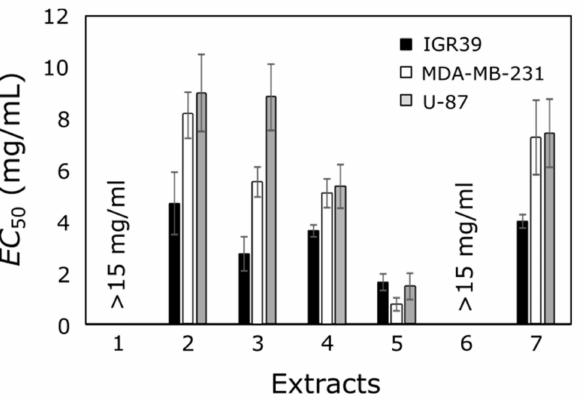
Figure 2. The EC 50 values of tested extracts against IGR39, MDA-MB-231, and U-87 cancer cell